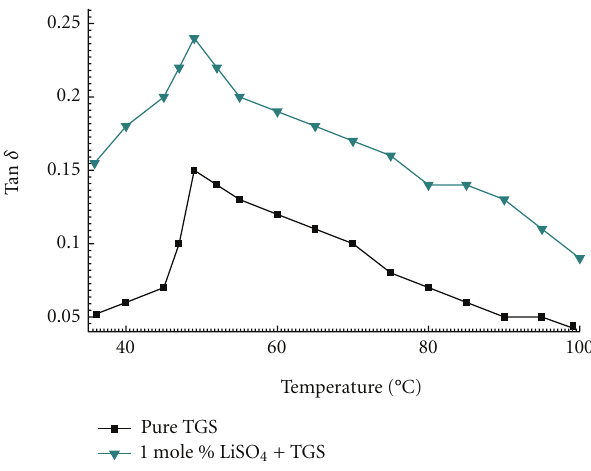
Figure 5: Graph for dielectric loss versus temperature of pure TGS and LiSO 4 -doped TGS crystals.